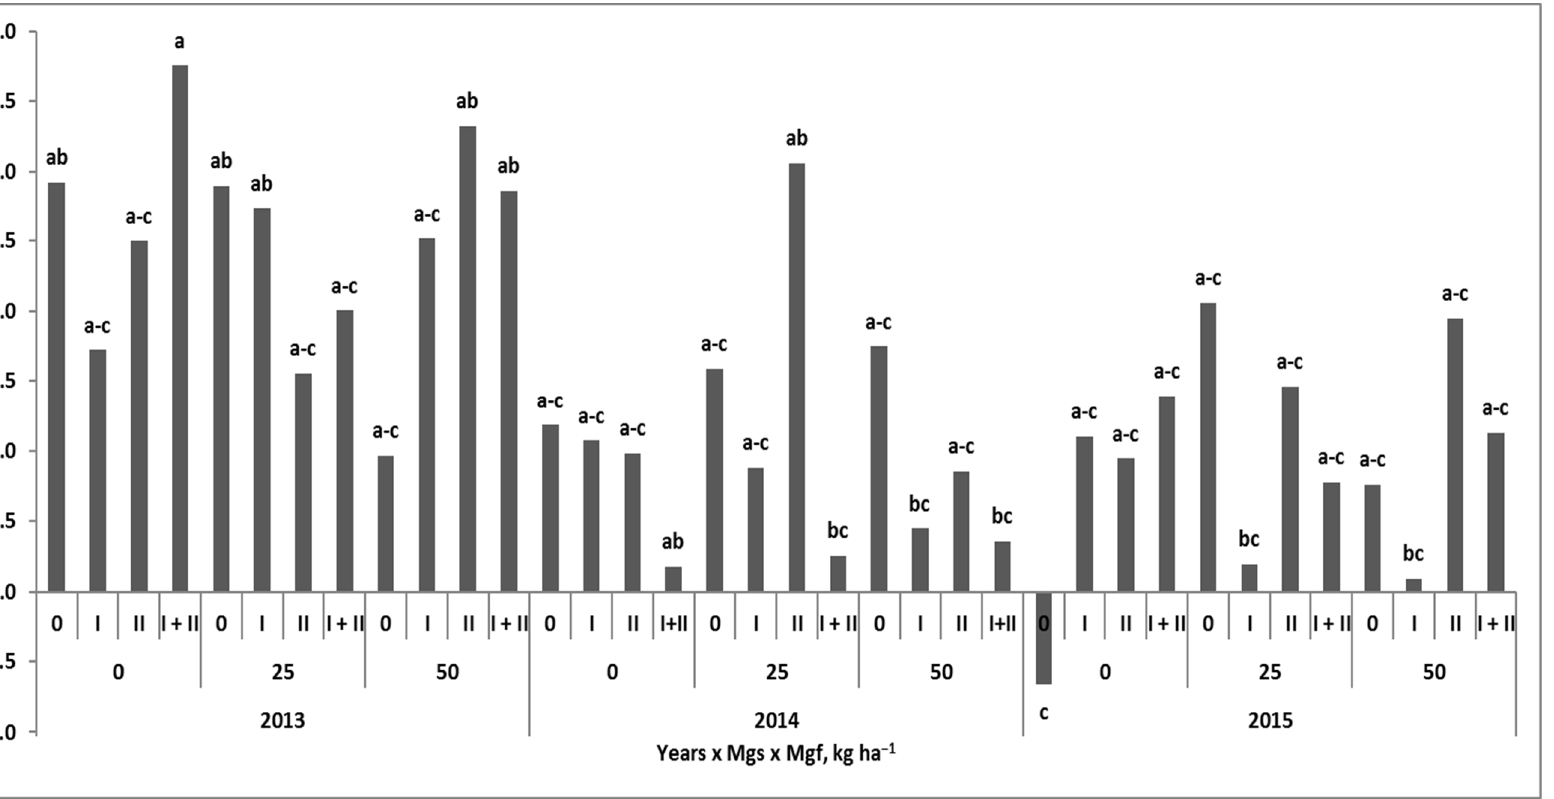
Figure 8. to BBCH 79. a,b,c similar letters mean a lack of significant differences using Tukey’s test. Legend: Mgs, Mgf—soil and foliar Mg fertilization systems, respectively; I—BBCH 30; II—BBCH 49/50.